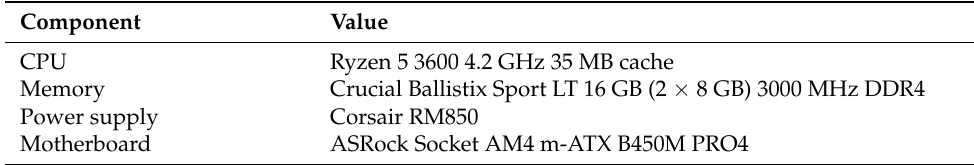
Table A1. Equipment used for the performance of the